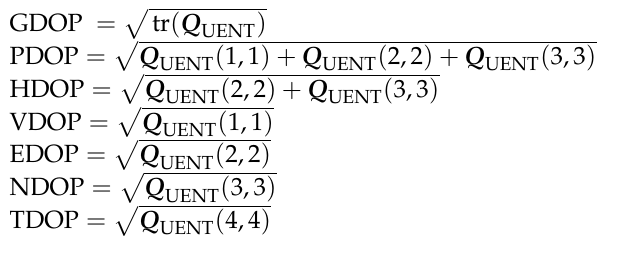
Table 1. Constellation parameters of four-GNSS and